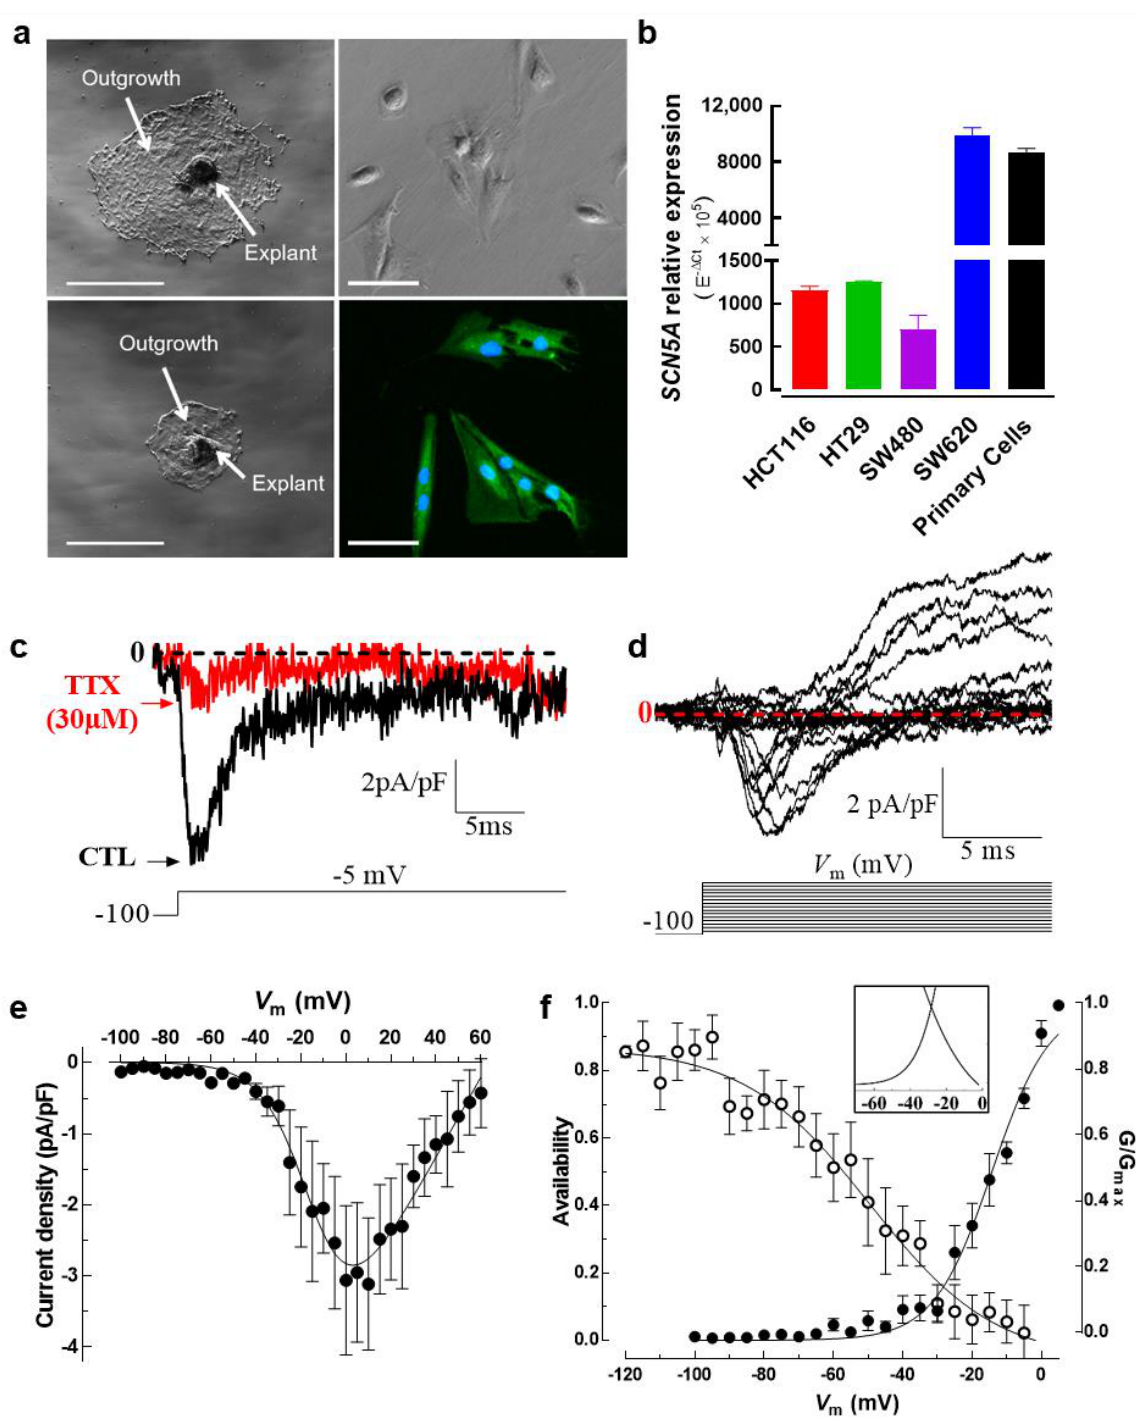
Figure 4. Establishment of tumor-derived primary cells from adherent explants of human colorectal tissue. ( a ) Resected endoscopic biopsies from colorectal tumors were washed, diced and enzymatically dissociated to produce explant cultures. Preparations from digested tissue were seeded in 6-well plates coated with collagen I (1 mg/mL) and incubated under standard conditions (37 °C, 5% CO 2 , water-saturated atmosphere). A daily follow-up control was performed to identify successful explants of colorectal tumors. Low magnification images using phase contrast microscopy showing two adherent explants surrounded by an outgrowth (middle panel section). Scale bar 300 µm. Phase contrast (upper right) and epifluorescence (lower right) microscopy images of tumor-derived primary cells obtained from explant cultures. Fluorescent image shows the staining for Na V 1.5 protein